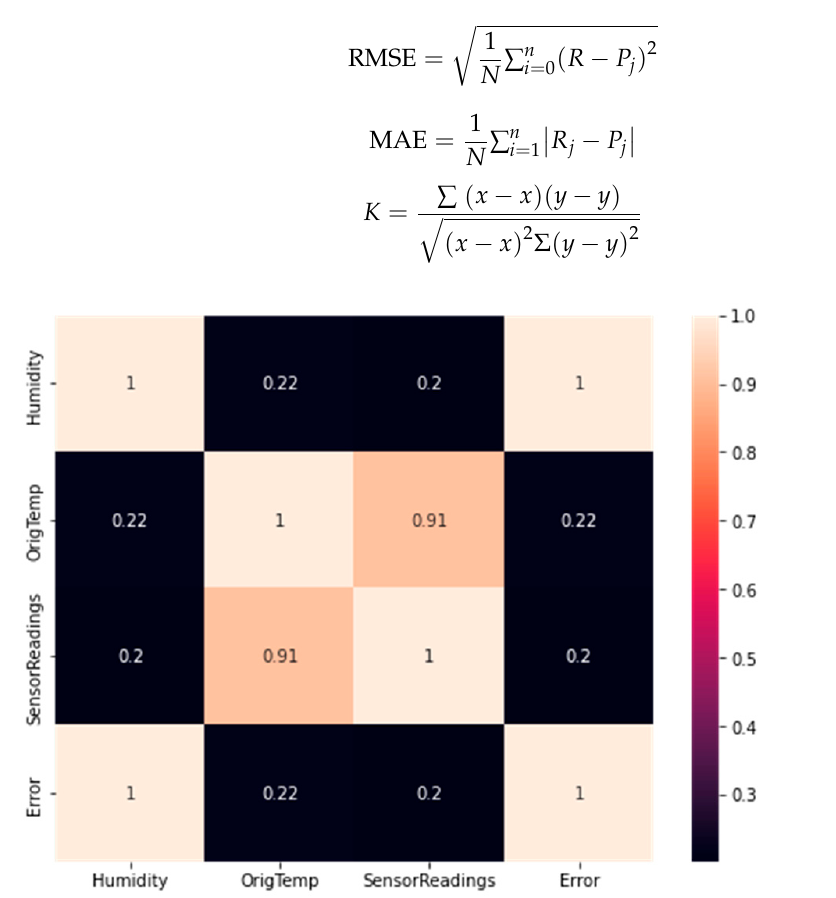
Figure 7. Heatmap representation of the correlation between training and testing datasets.